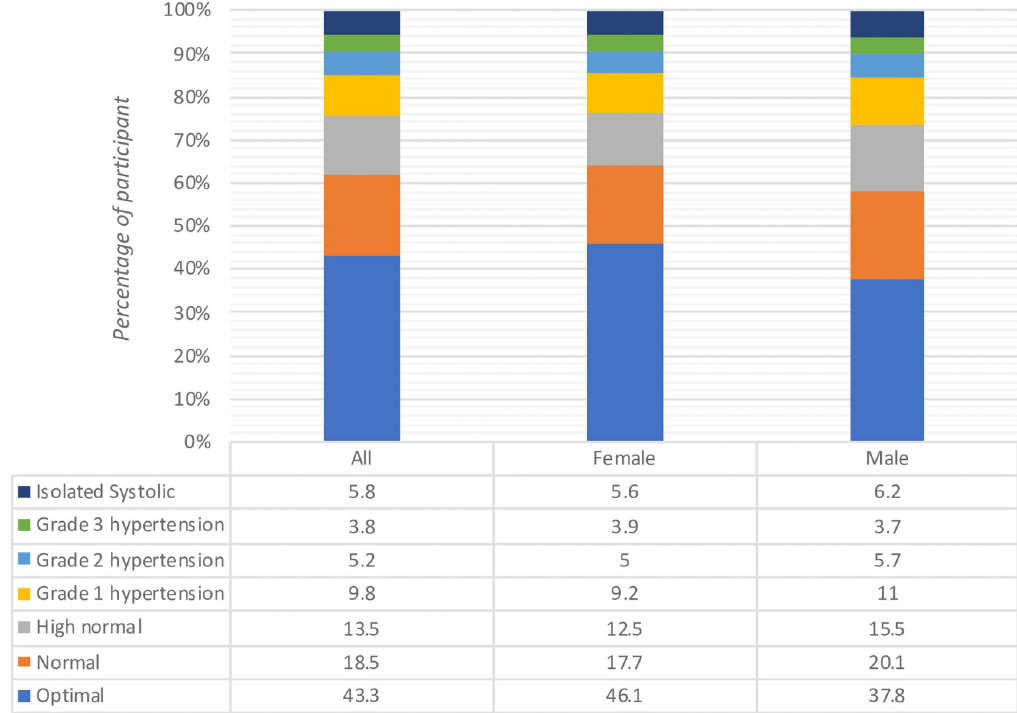
Fig 2. Grade of blood pressure by 2018 ESC/ESH guidelines for the overall group (left), female (middle) and male (right).